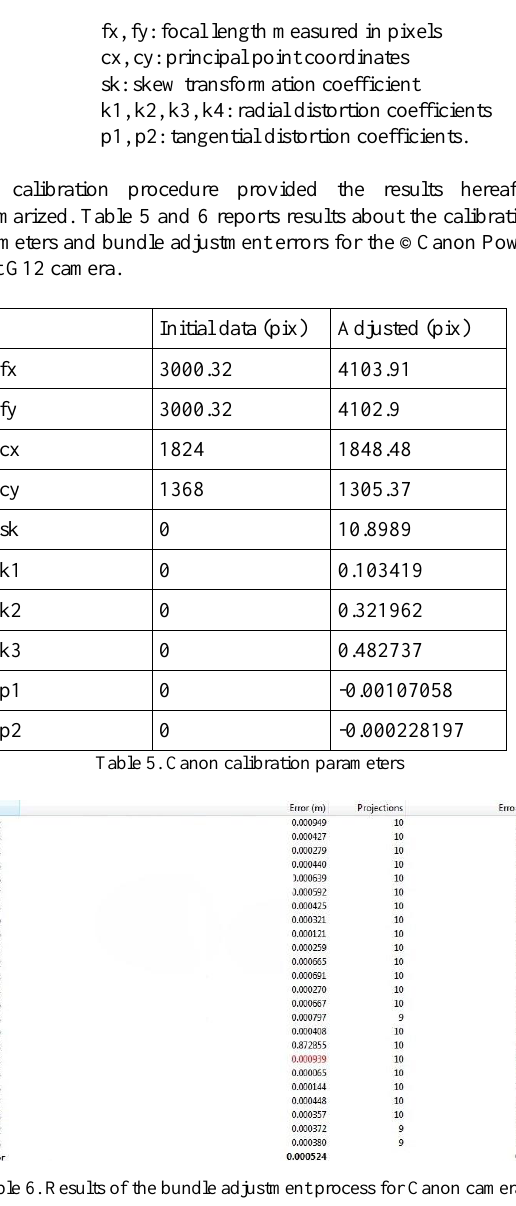
Table 6. Results of the bundle adjustment process for Canon